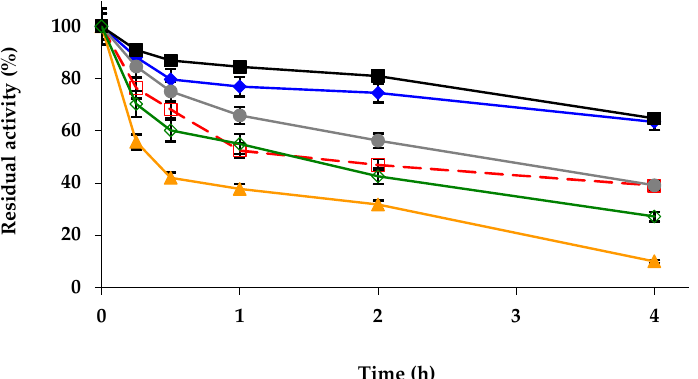
Figure 1. Inactivation courses of different physically and chemically modified octyl-TLL biocatalysts. The biocatalysts were inactivated at 68 ◦ C, in presence of 10 mM Tris-HCl buffer at pH 7.0. Other specifications are described in Methods. Unmodified octyl-TLL (empty squares and dashed and red line); octyl-TLL modified with 1% glutaraldehyde (solid rhombus and solid blue line); amination using 2 M ethylenediamine (solid triangles and solid orange line); 1 mM picrylsulfonic acid (solid circles and solid grey line); 10% polyethylenimine (solid squares and solid black line); 10% dextran sulfate (empty rhombus and solid green line).